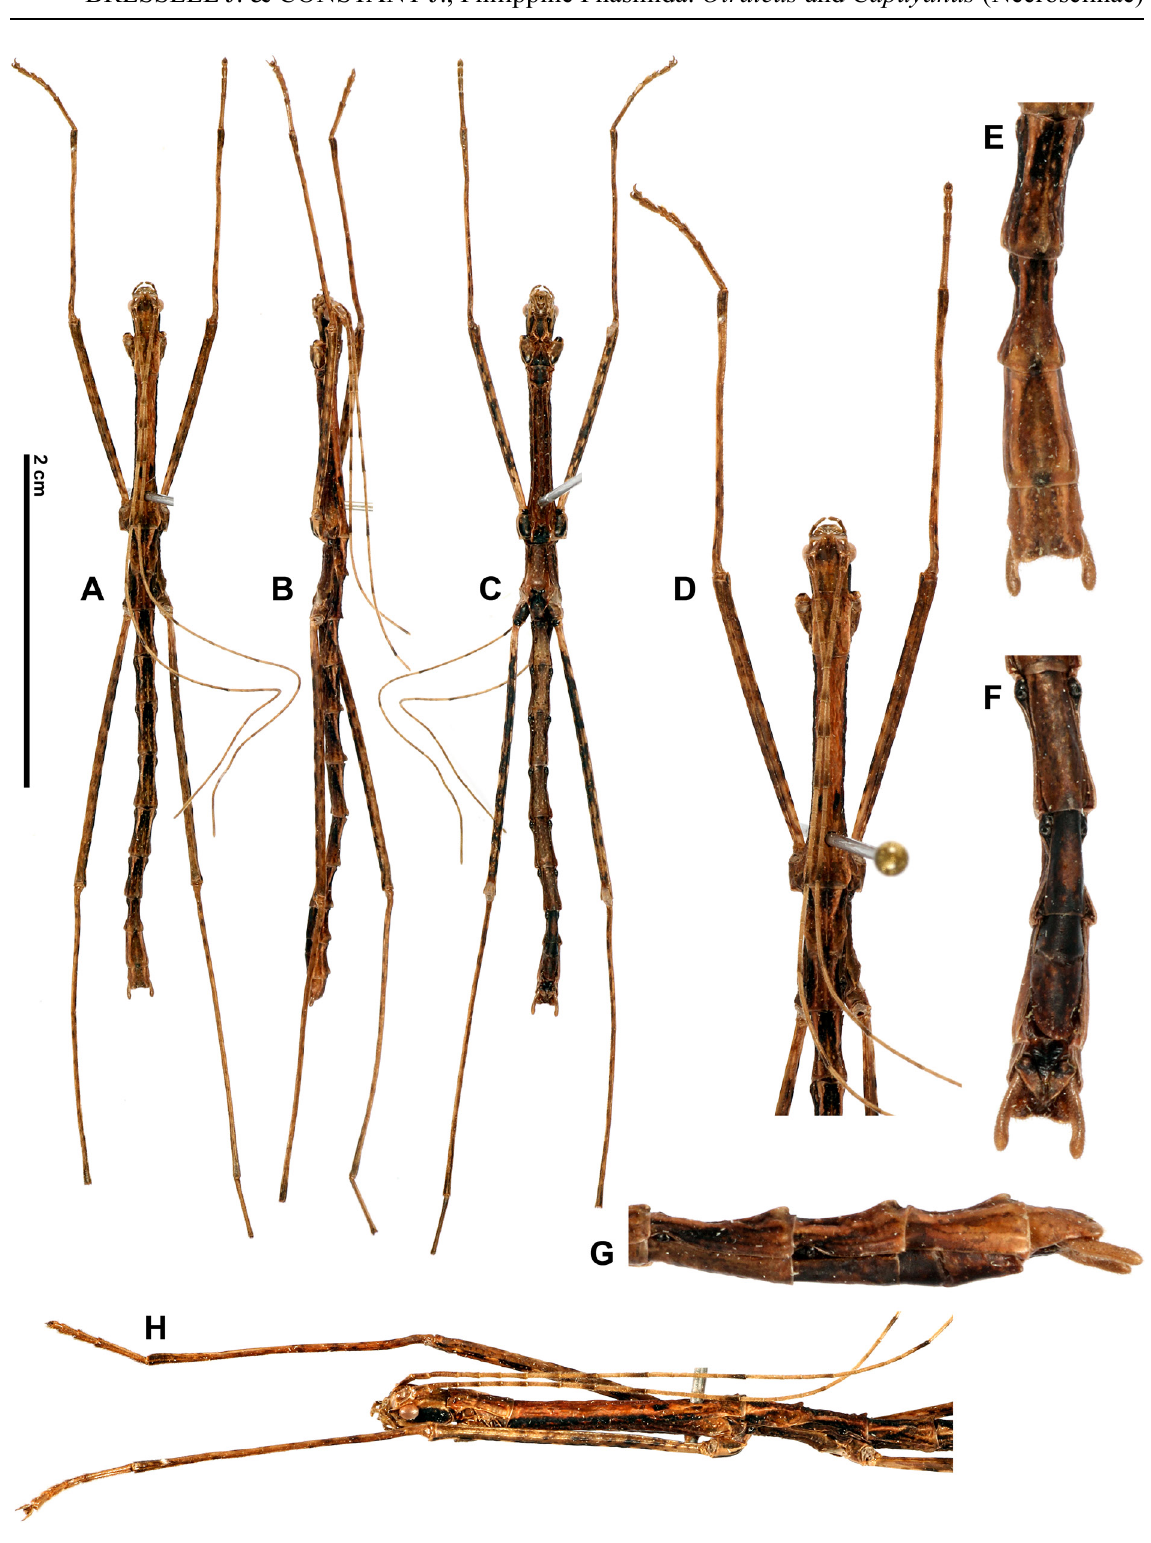
Fig. 15. Capuyanus magwilangi gen. et sp. nov., ♂, holotype. A . Habitus, dorsal view. B . Habitus, lateral view. C . Habitus, ventral view. D . Anterior part of body, dorsal view. E . Apex of abdomen, dorsal view. F . Apex of abdomen, ventral view. G . Apex of abdomen, lateral view. H . Anterior part of body, lateral view. D–H: not to